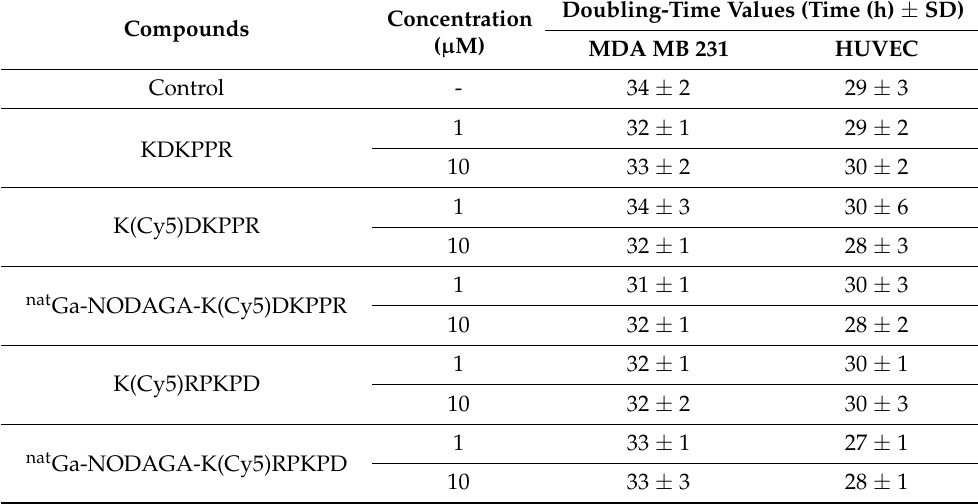
Table 3. Doubling-time values (Time (h) ± SD) of the MDA-MB-231 and HUVEC cells exposed to NRP-1-targeting or nontargeting compounds (0–10 µ M) calculated during the exponential phase of cell